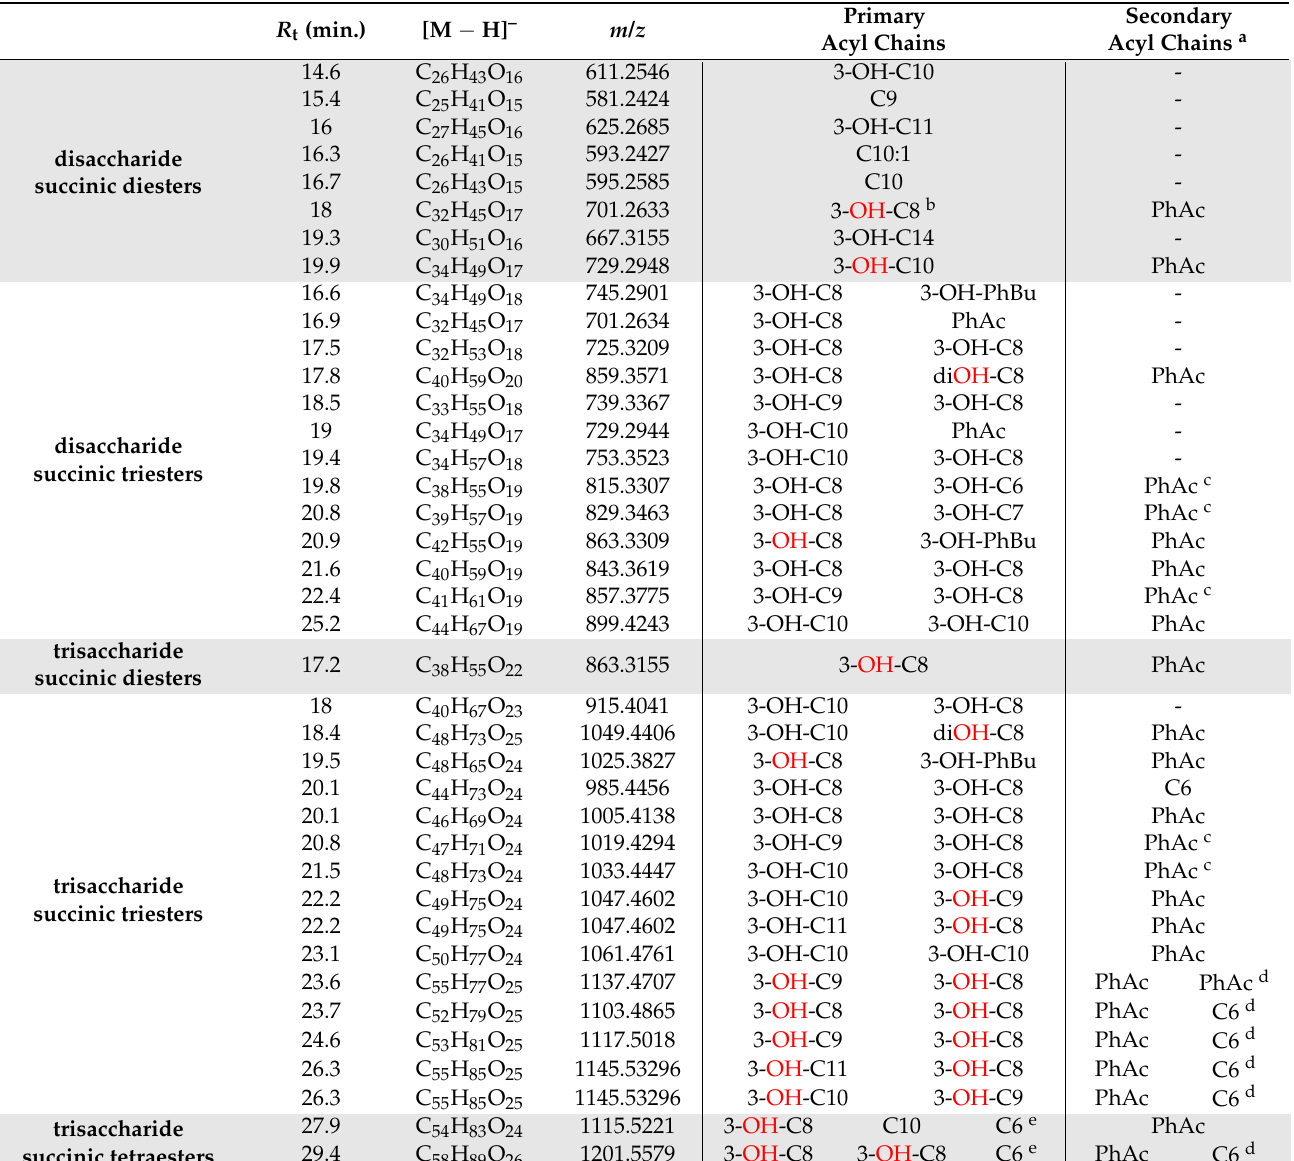
Table 3. Succinoyl saccharide esters from Rhodococcus sp. I2R. R t